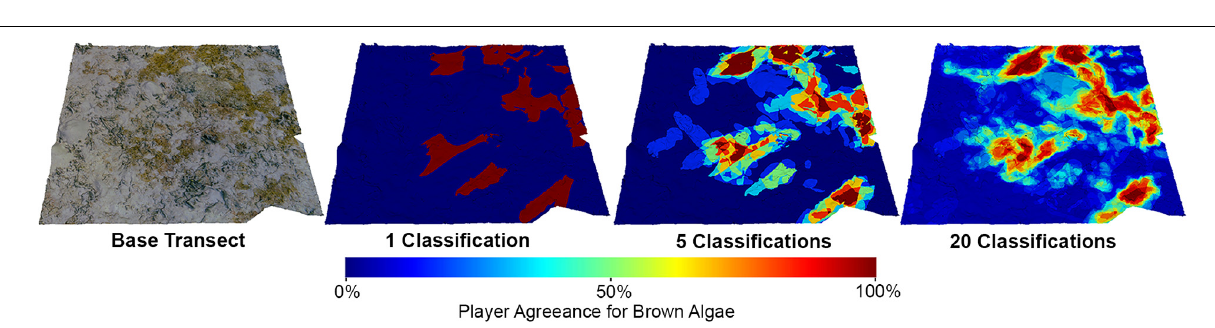
FIGURE 10 | An example of a 3D dataset showing that the NeMO-Net game and active learning framework can effectively aggregate user labels to improve overall classification quality. Player classifications tighten and show on stronger boundary delineation when taking the combination of many players as